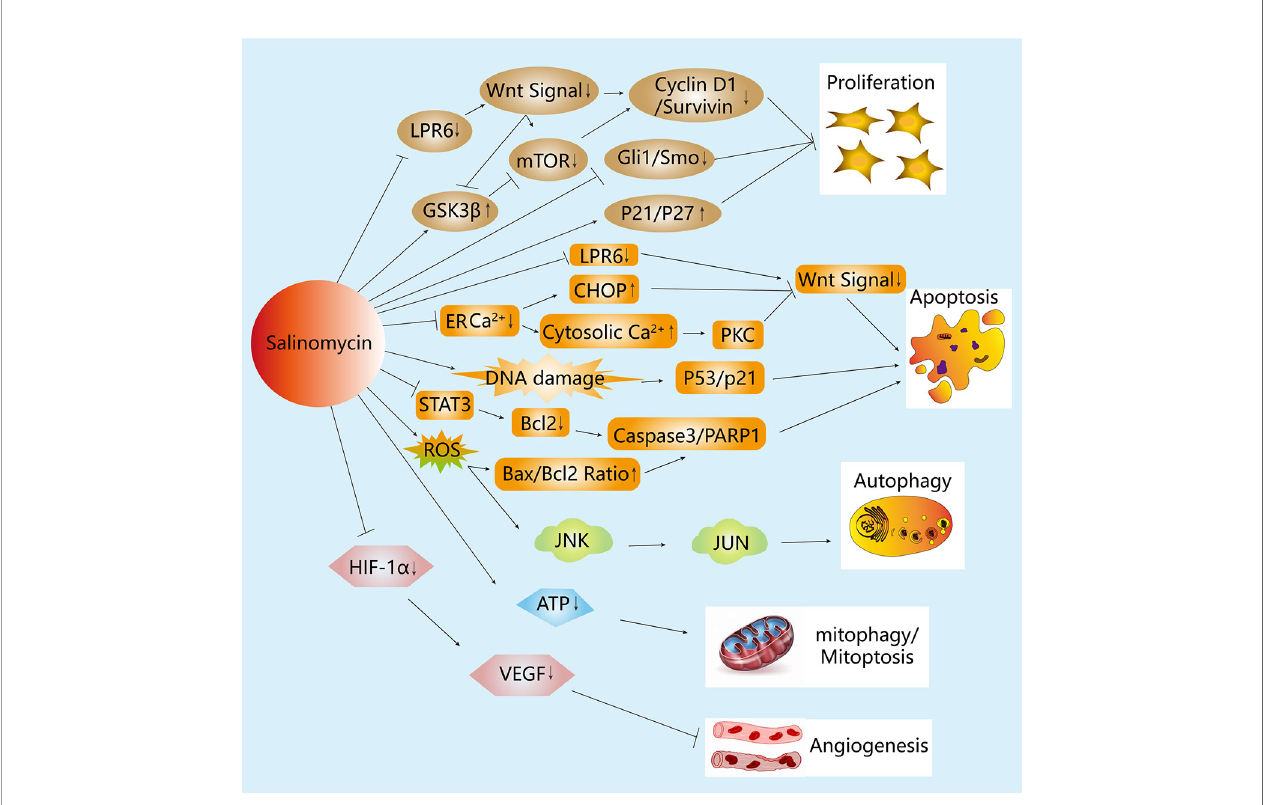
FIGURE 2 | Mechanisms of the anticancer activity of salinomycin in breast cancer (BC) cells. Salinomycin inhibits cell proliferation in BC cells through the Hedgehog and Wnt signaling pathways. Additionally, salinomycin is capable of inhibiting Wnt signaling by blocking the phosphorylation of LRP6 or by ER stress, which leads to apoptosis in BC cells. Moreover, salinomycin induces the apoptosis of BC cells by increasing DNA damage or intracellular ROS level, thereby in fl uencing the p53 and caspase cascade separately. Salinomycin also induces autophagy by increasing intracellular ROS level, which is accompanied by MAPK signaling pathway activation. Furthermore, salinomycin can affect the cell membrane potential and reduce the level of ATP to induce mitophagy and mitoptosis. Moreover, salinomycin inhibits angiogenesis through the VEGF signaling